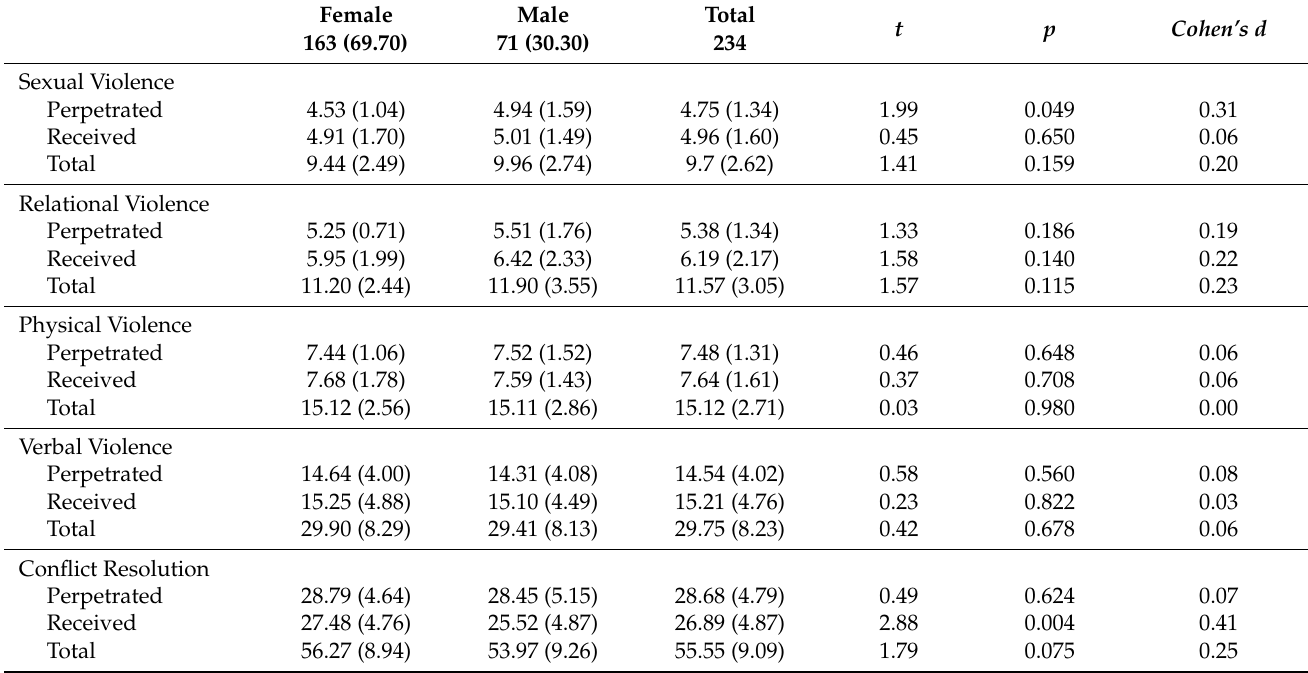
Table 3. Subscale scores on the Conflict in Adolescent Dating Relationship Inventory (CADRI) according to the gender of the